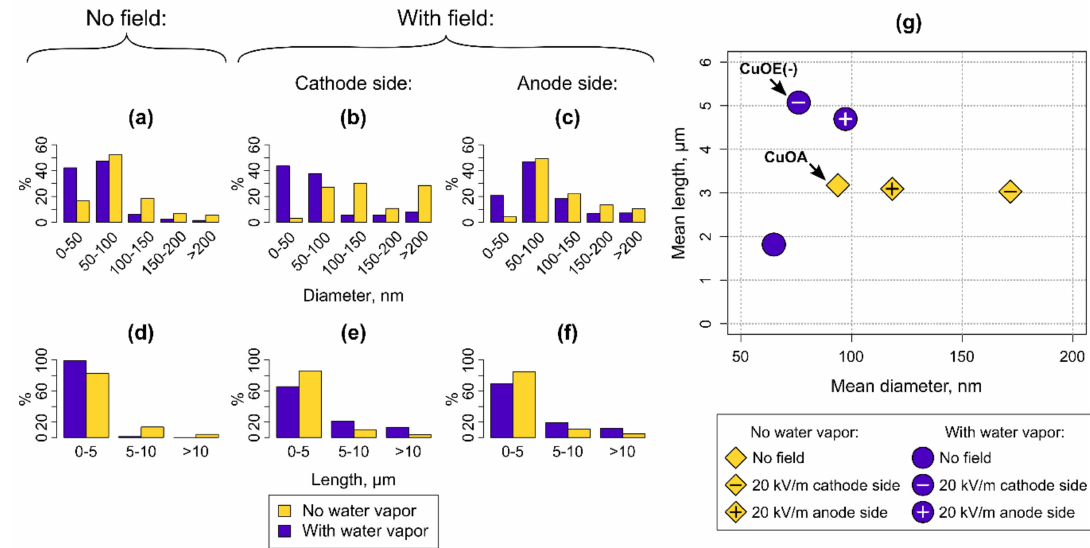
Figure 4. ( a – c ) Diameters and ( d – f ) lengths of CuO nanowires: ( a ) and ( d ) with no electric field; ( b ) and ( e ): with an applied 20 kV / m electric field on the cathode side of the substrate; ( c ) and ( f ) with an applied 20 kV / m electric field on the anode side of the substrate; ( g ) mean diameters and lengths of CuO nanowires synthesized by di ff erent methods. The nanowires selected for the mechanical